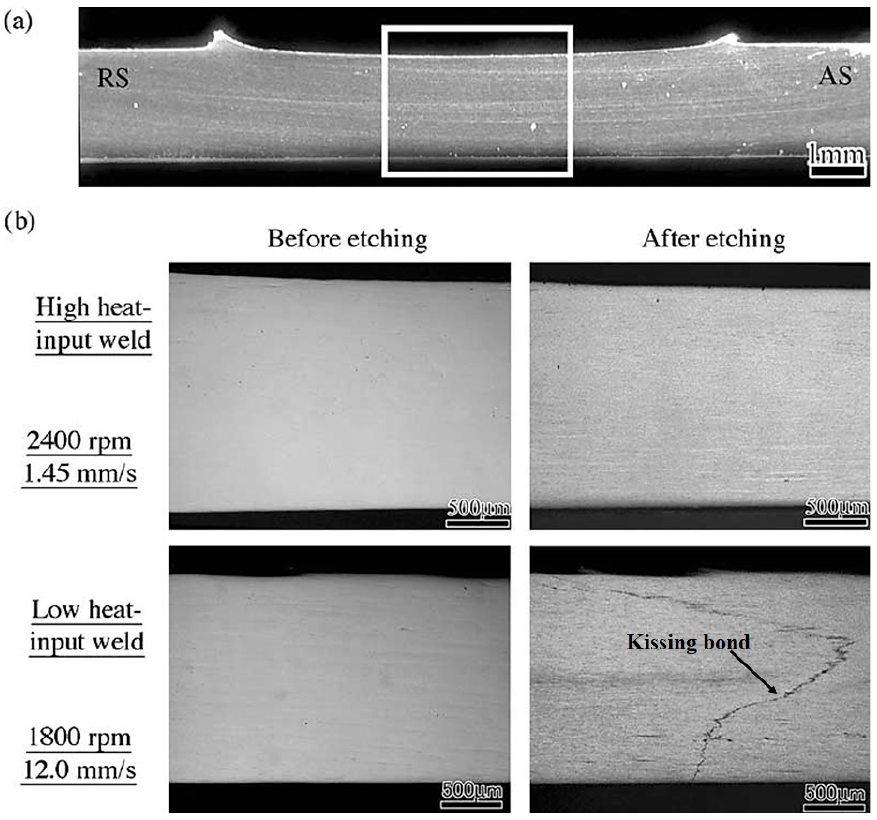
Figure 8. ( a ) Cross-section of the as-polished weld and ( b ) Optical micrographs of the welds produced by two welding parameters before and after etching [122]. Reprinted from: Characteristics of the kissing-bond in friction stir welded Al alloy 1050. Materials Science and Engineering: A 405, no. 1–2 (2005): 333–338, Sato, Yutaka S., Hideaki Takauchi, Seung Hwan C. Park, and Hiroyuki Kokawa,